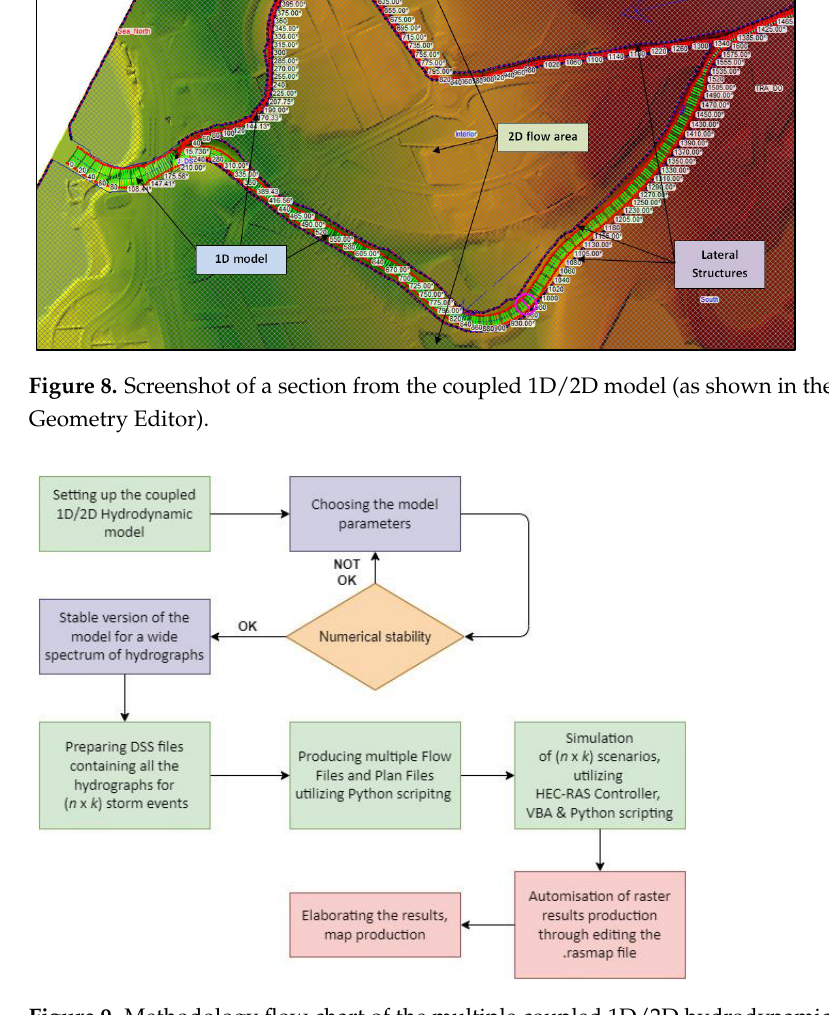
Figure 9. Methodology flow chart of the multiple coupled 1D/2D hydrodynamic model runs.